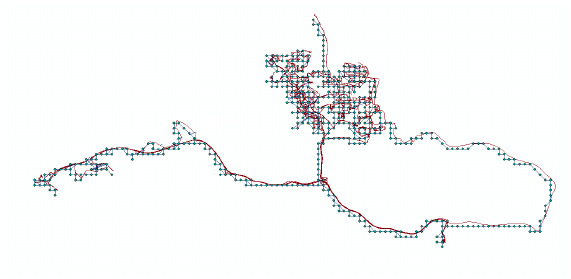
Figure 10: Grid-based masking - points inside 250*250 m grid cells are recalculated as centroids of the particular cells and the new trajectories are derived.